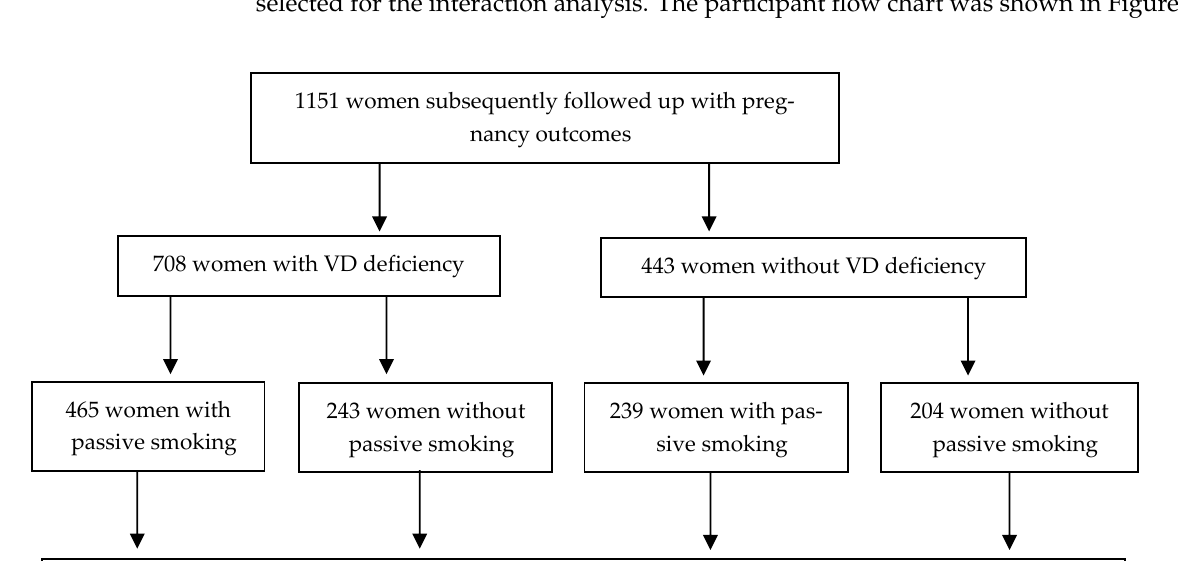
Figure 2. Participant flow chart of effort of passive smoking and inadequate dietary nutrition on the risk of vitamin D deficiency analysis.